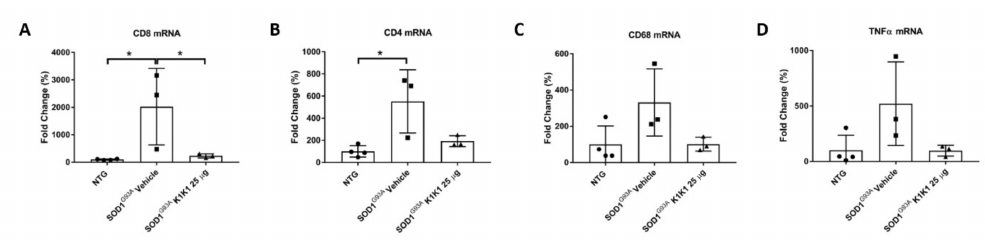
Figure 6. Treatment with 25 µ g K1K1 dampens the inflammatory response in Tibialis Anterior muscles of SOD1G93A mice. ( A – D ) Real time PCR shows that 25 µ g K1K1 decreases CD8 + ( A ) and CD4 + T ( B ) cells in Tibialis Anterior Muscle. For the mediators of inflammation CD68 ( C ) and TNFa ( D ) we observe a reduction after treatment with 25 µ g K1K1. Data are expressed as the mean ± SEM as percentage of NTG ( n = 3–5 mice per group). All data were statistically analyzed using One-way ANOVA followed by post hoc Fisher’s LSD. * p < 0.05.